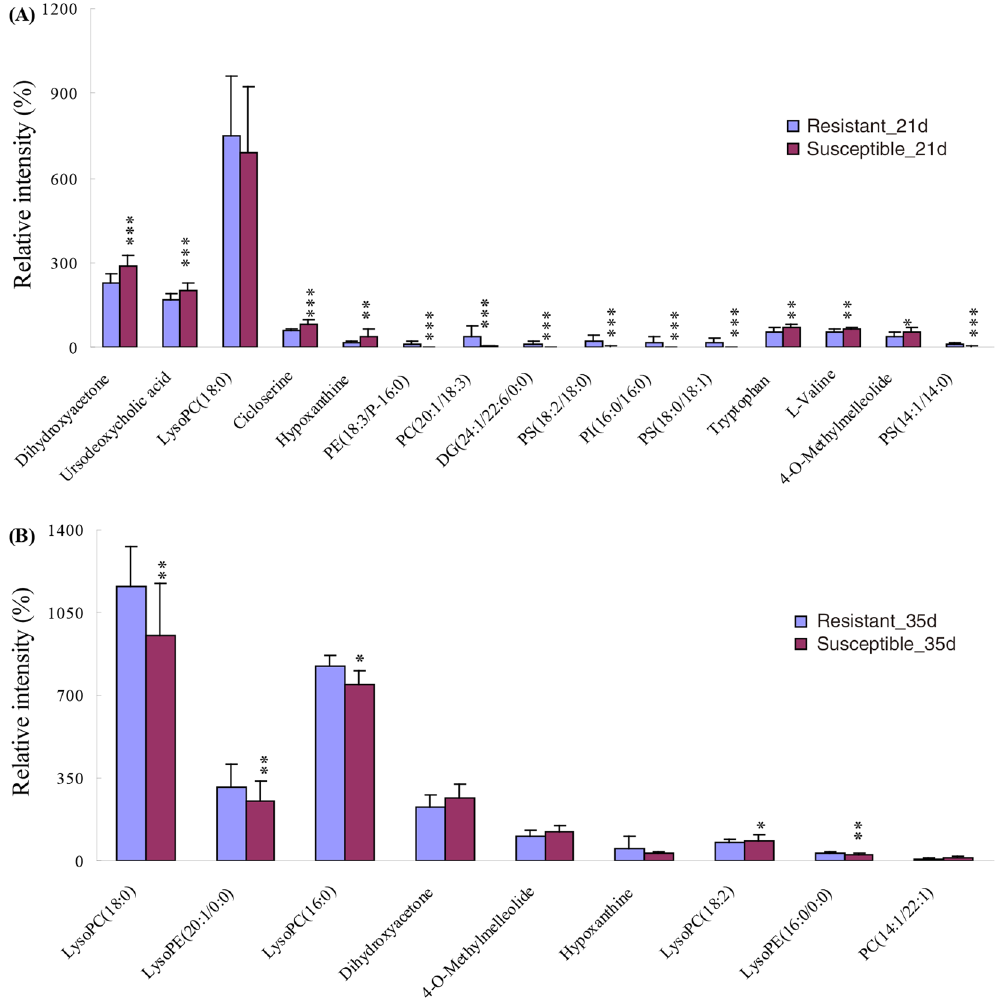
Figure 8. Comparison of the relative intensity of putative potential biomarkers in the resistant group and susceptible group on day ( A ) 21 and ( B )